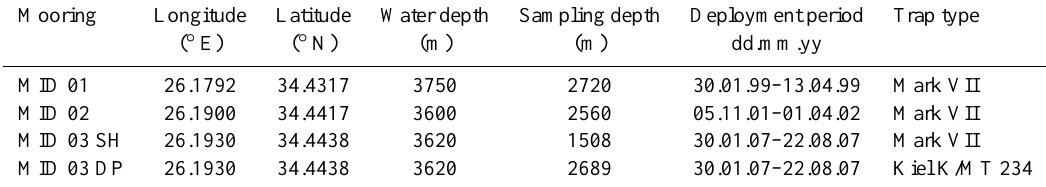
Table 1. Sediment trap moorings in the Ierapetra Deep: position, water depth, sampling depth, deployment period and trap type. Mooring